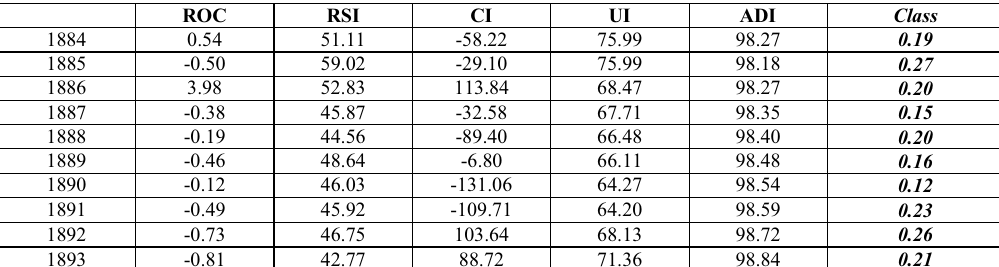
Fig.3. Converted Sample rainfall dataset by five technical